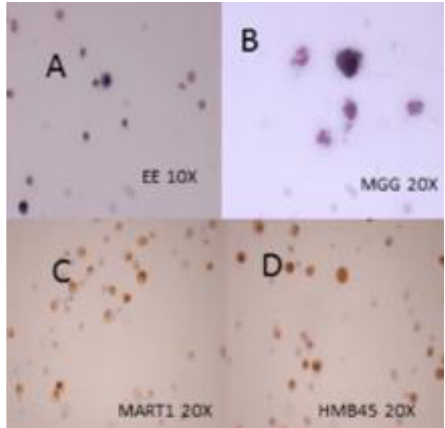
Figure 3. At cytological examination of the cerebrospinal fluid (CSF) stained with hematoxylin-eosin ( A ) and May – Grunwald – Giemsa ( B ) neoplastic cells with abundant pigmented cytoplasm, large vesicular nuclei and prominent nucleoli can be noted; immunocytochemical positivity for Mart1 ( C ) and HMB45 ( D ) confirms the hypothesis of melanoma.